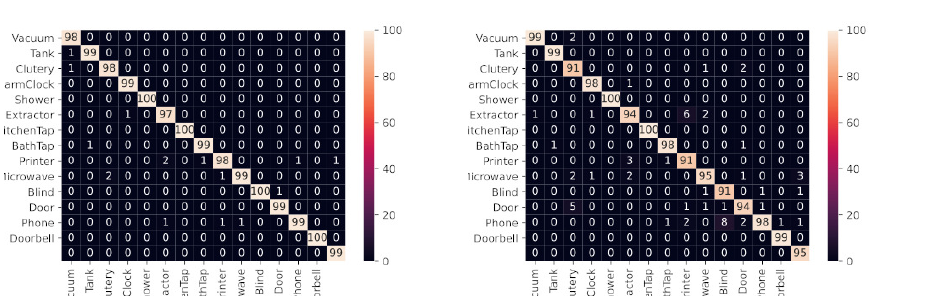
Figure 4. Confusion matrices in ad hoc ambient audio dataset. ( Left ) CNN + MFCC; ( Right ) CNN + LM.